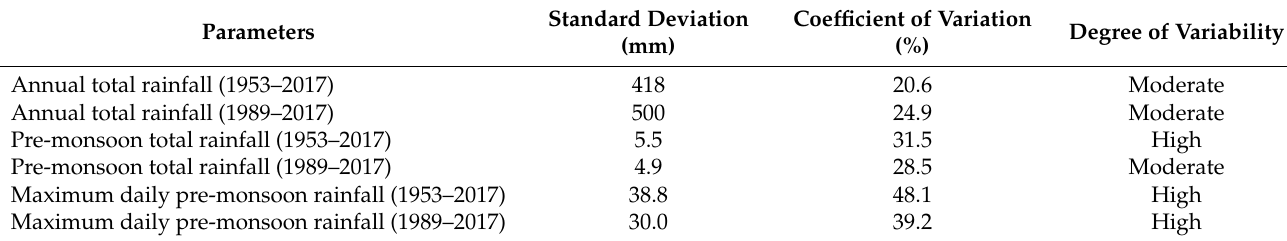
Table 5. Variability in different rainfalls at